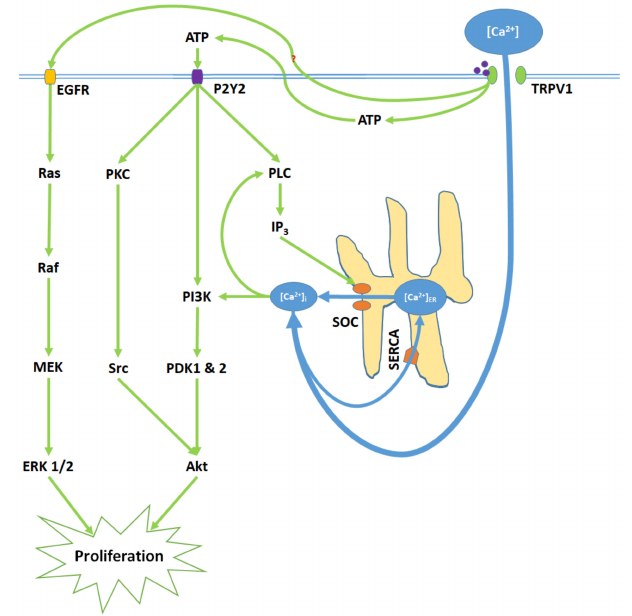
Figure 2. TRPV1 induces proliferation through Ca 2 + entry, ATP release and membrane P2Y2 receptor activation, and the transactivation of epidermal growth factor receptor (EGFR). Elevated [Ca 2 + ] i and ATP-P2Y2 binding upregulate intracellular IP 3 via phospholipase C (PLC); IP 3 opens store-operated channels (SOC) and thereby causes Ca 2 + release from the ER. Activated P2Y2 receptors also begin the PI3K / Akt pathway, a kinase signaling cascade that ultimately activates Akt. TRPV1 additionally transactivates EGFR; this prompts Ras / Raf / MAPK-ERK kinase (MEK) / extracellular signal-regulated kinase (ERK) signaling, which upregulates ERK 1 / 2 mitogen-activated protein kinases (MAPK). Akt and ERK 1 / 2 MAPK promote proliferation through nuclear